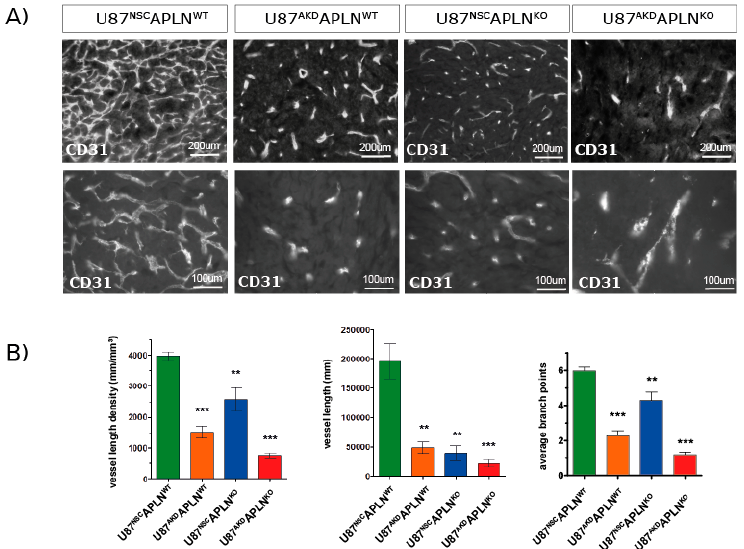
Figure 3. GBM-and endothelial cell-derived APLN are both controlling sprouting angiogenesis. ( A ) U87MG was implanted into immunodeficient mice and grown to big xenografts within 28 dpi. Fluorescent immunostaining for CD31 was performed and is depicted in an overview and a close up view for every xenograft. ( B ) The microvasculature in the green fluorescent protein (GFP)-positive tumor area was analyzed by stereomorphology. In comparison to U87 NSC APLN WT controls ( n = 8), VLD in U87 AKD APLN WT xenografts ( n = 13) was reduced by 62% and vessel length by 75%. Additional loss-of- APLN expression in the tumor neo-vasculature of the APLN KO mouse (U87 AKD APLN KO , n = 10) lead to further reduction of the tumor vasculature. VLD was also reduced when only the tumor cells express APLN (U87 NSC APLN KO , n = 9) but was the highest of all manipulated xenografts. While vascular complexity measured by vascular branch points (ABP values are 6, 2.3; 4.3; and 1.2, respectively) reflects the results seen by VLD, the total vessel length was highly reduced in all three xenografts with reduction of APLN expression. Data are reported as mean +/ − SEM; statistical significance (one-way ANOVA plus Bonferroni´s post hoc test) is indicated ** p < 0.005, *** p <